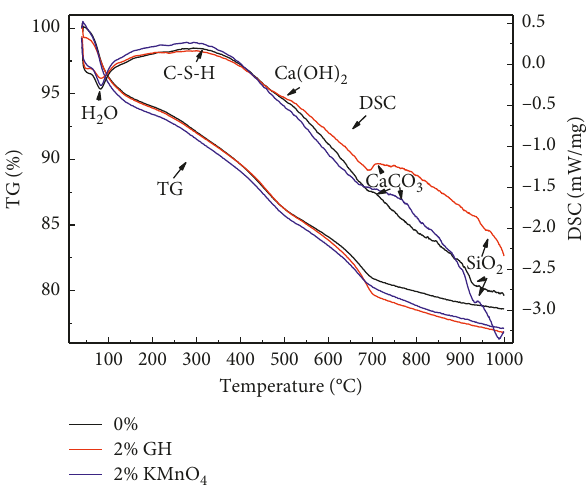
Figure 7: TG-DSC curves of the different samples after curing for 28